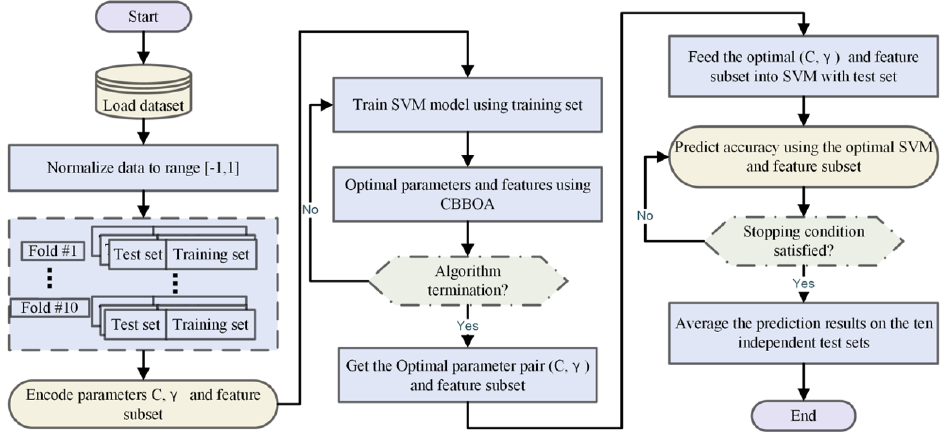
Figure 2. Flowchart of the CBBOA-SVM model.